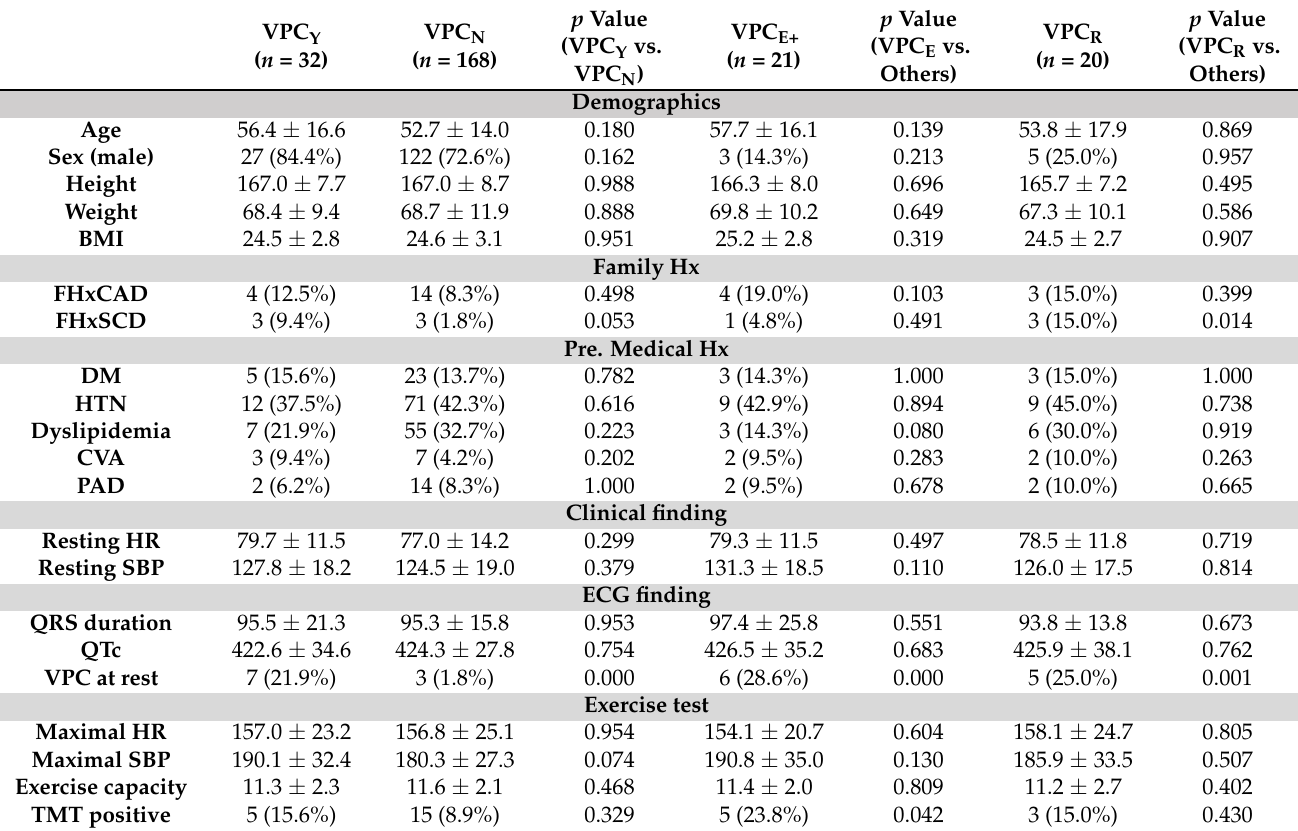
Table 1. Baseline characteristics ( n =